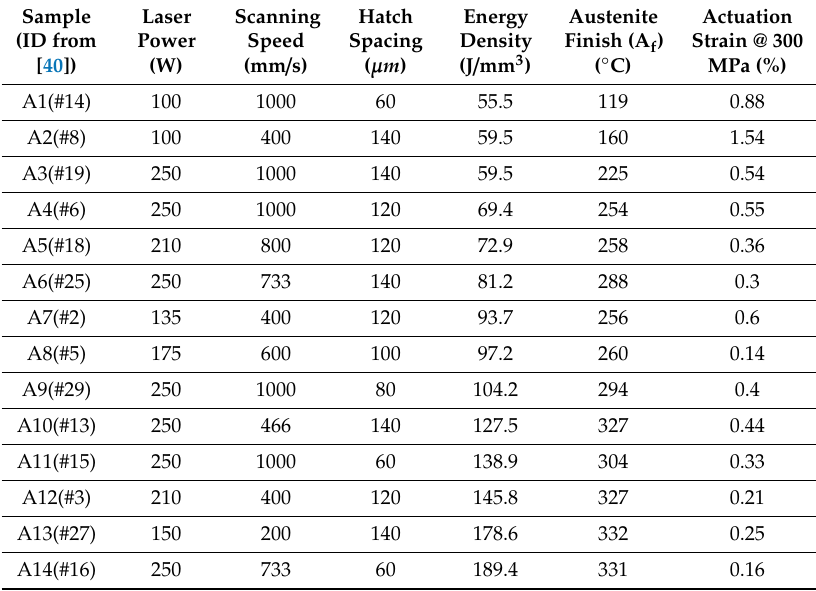
Table 1. SLM process parameters used for fabrication of cuboid samples. A18-A30 were not tested and no data is available for the actuation